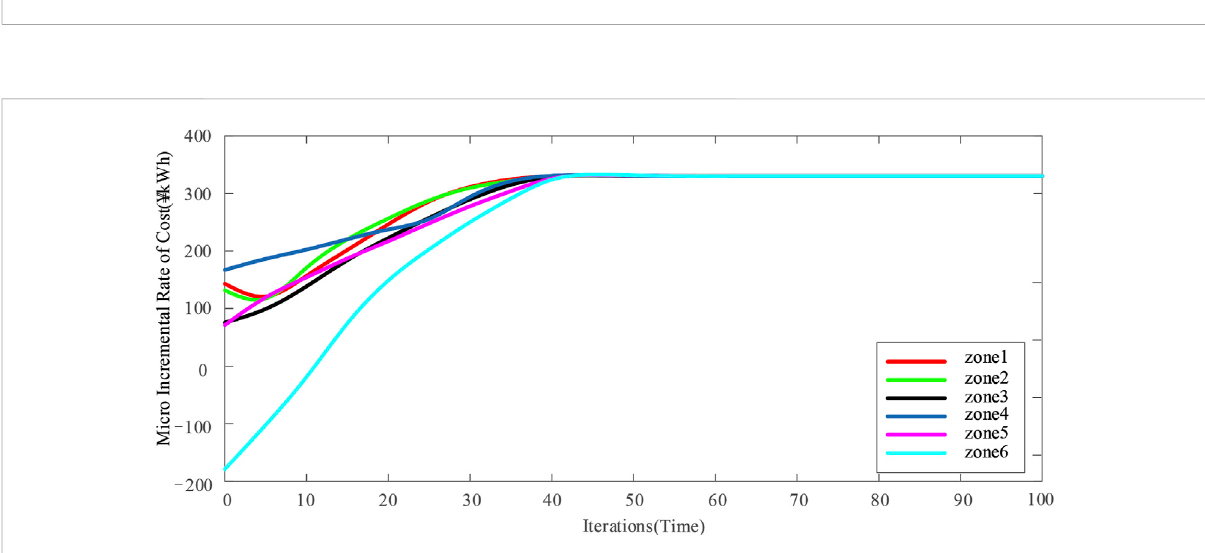
FIGURE 5 Adjustable active power prediction value of each distribution transformer supply zone on a long timescale.